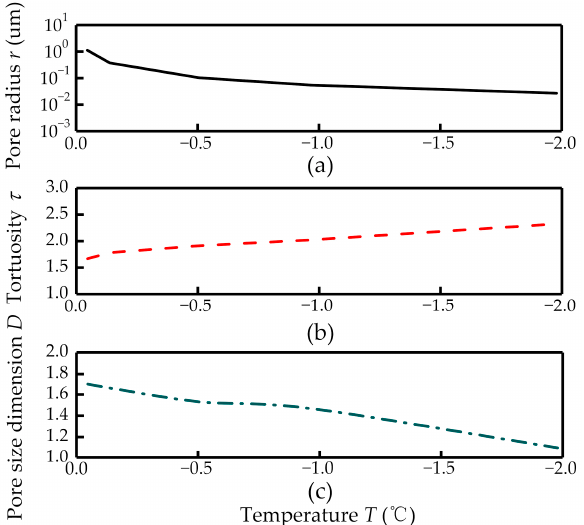
Figure 7. Variation of pore size dimension ( a ), maximum pore radius ( b ) and tortuosity ( c ) with